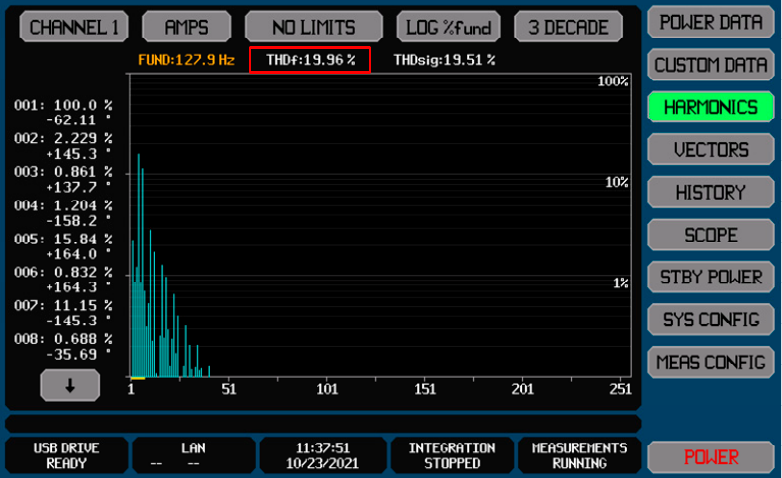
Figure 26. Output current THD i of the commercially available drive at rotational speed frequency command of 150 Hz.